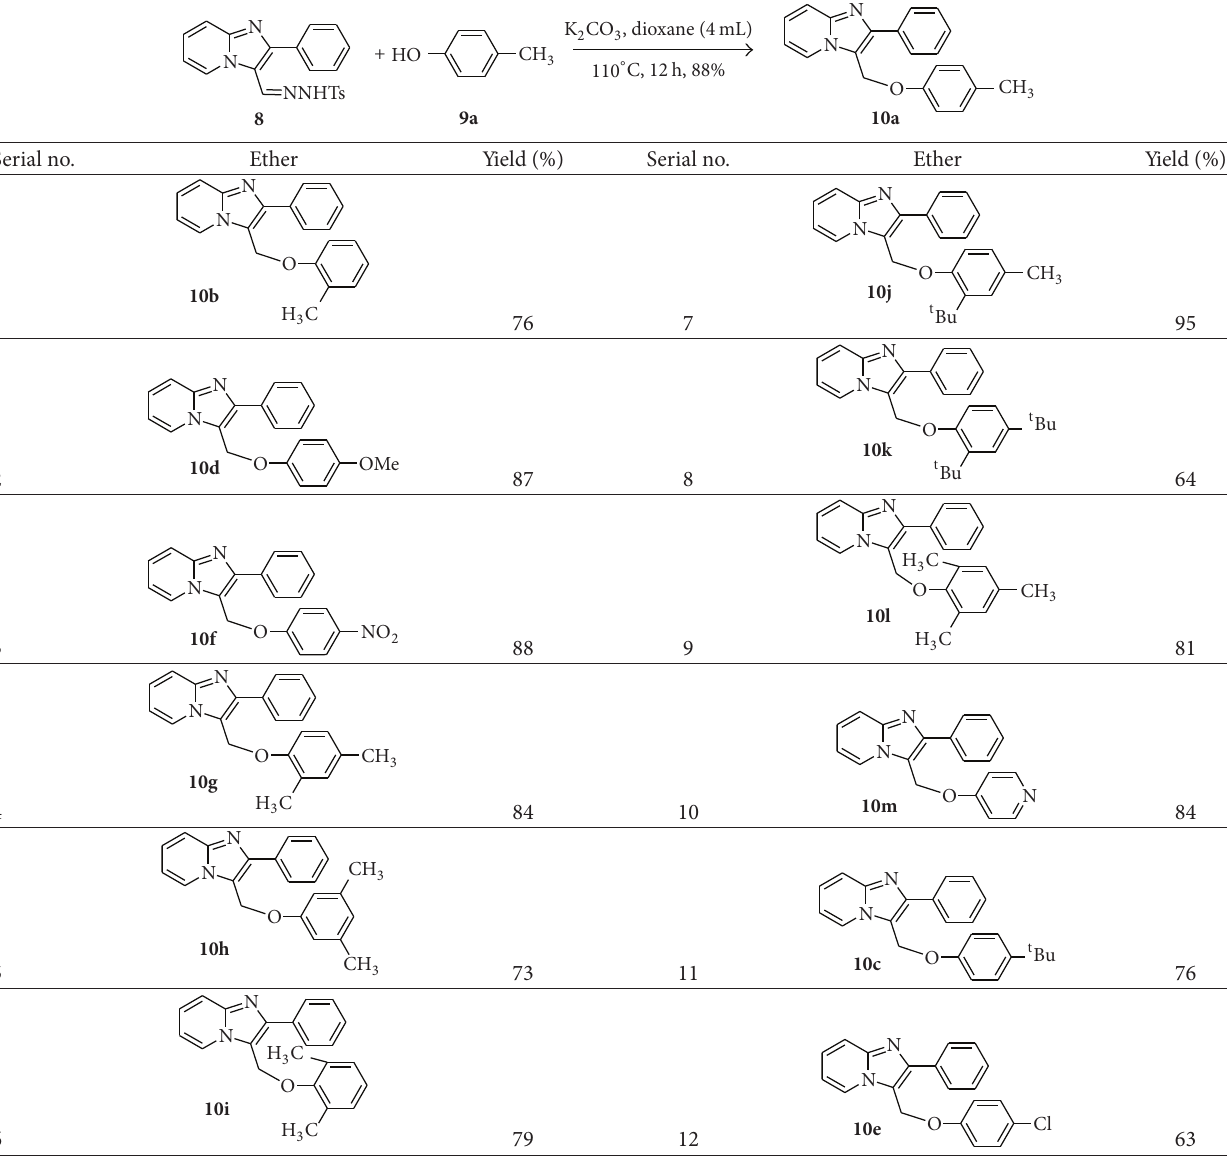
CO (3.5mmol) dioxane (4.0mL), 110 C, 12h. b Yield refers to pure and 2 3 ∘